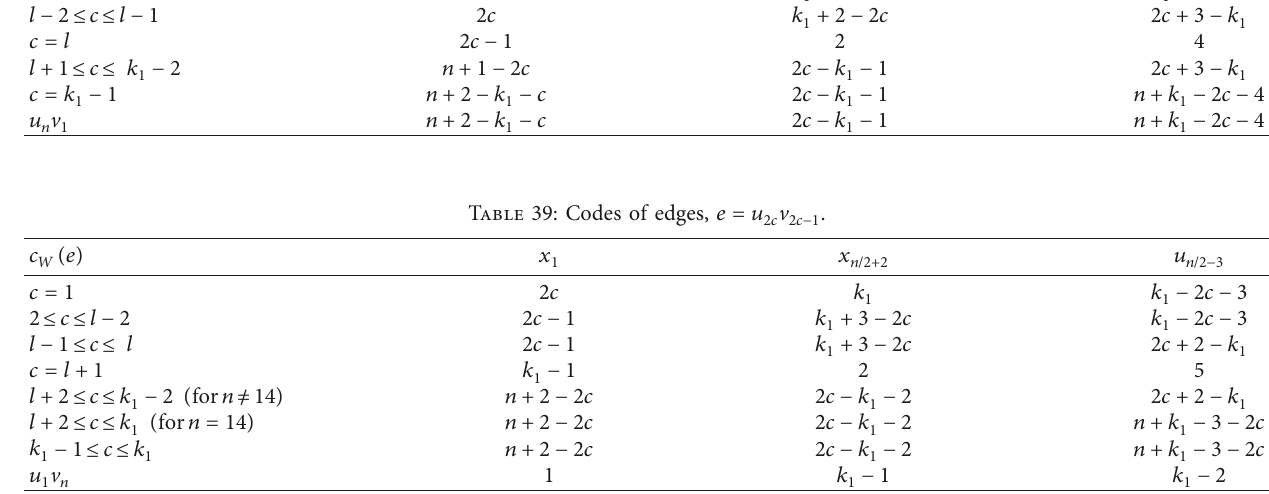
Table 38: Codes of edges, e � u